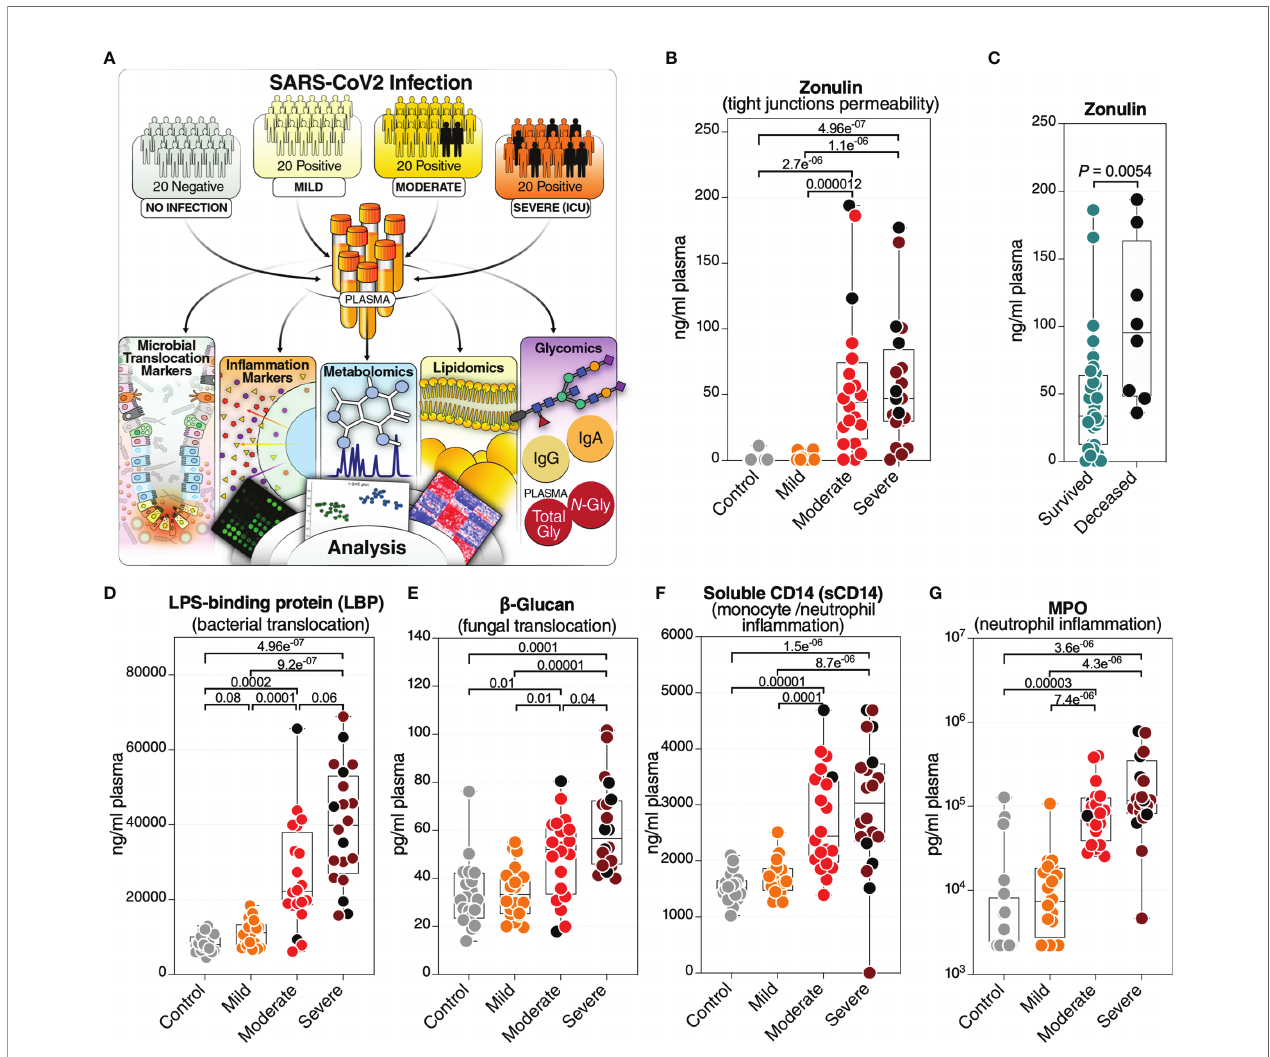
FIGURE 1 | Severe COVID-19 is associated with an increase in markers of tight junction permeability and microbial translocation. (A) An overview of the main cohort study design; moderate and severe patients were hospitalized; severe indicates patients in the intensive care unit. (B) Levels of plasma zonulin, are higher during moderate and severe COVID-19 compared to mild COVID-19 or controls. Kruskal – Wallis test was used for statistical analysis. False discovery rate (FDR) was calculated using the Benjamini-Hochberg method. Symbols in black indicate deceased. (C) Zonulin levels are higher in hospitalized COVID patients (n=40) who eventually died from COVID-19 (n=8) compared to survivors (n=32). Nominal P-value was calculated using the Mann – Whitney U test. (D – G) Levels of LBP (D) , b -Glucan (E) , sCD14 (F) , and MPO (G) , are higher during severe COVID-19 compared to mild COVID-19 or controls. Kruskal – Wallis test was used for statistical analysis. FDR was calculated using Benjamini-Hochberg method. Black dots indicate